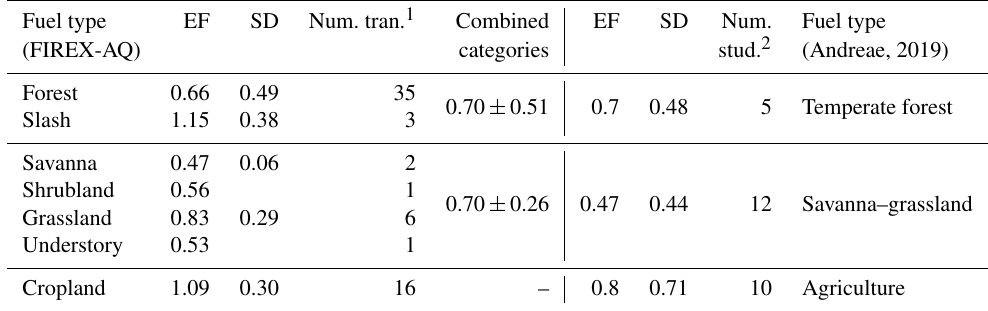
Table 1. Comparison of the flaming stage SO 2 EFs (gkg − 1 C) by fuel type as measured during FIREX-AQ (left) to the compiled values reported in Andreae (2019) (right).